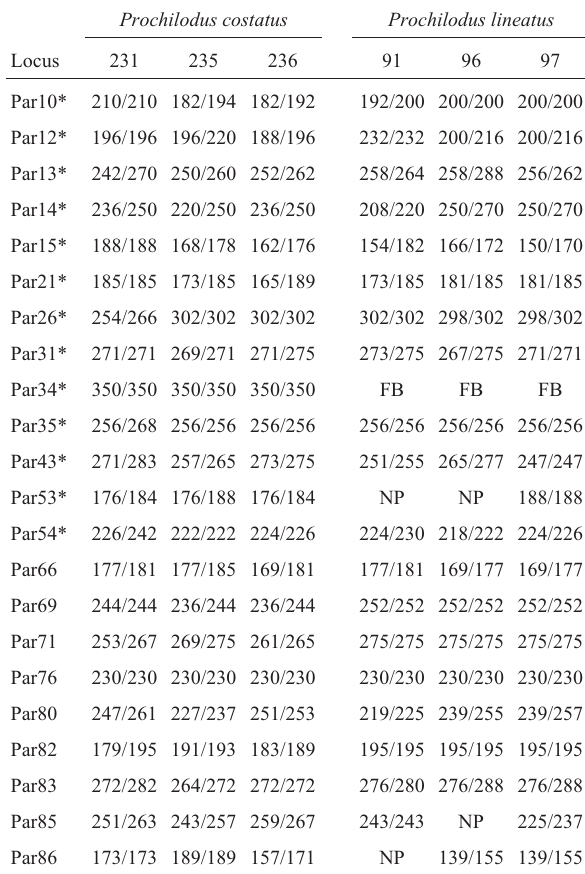
Table 2 - Sample genotypes with allele sizes in base